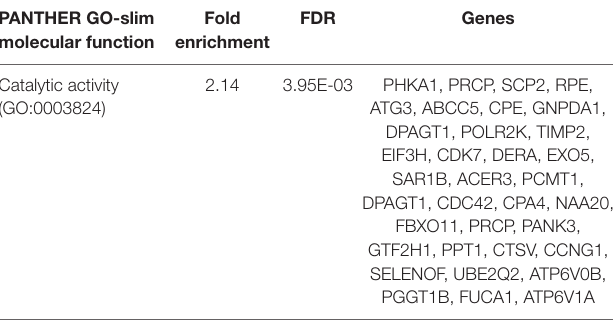
TABLE 9 | Enrichment of genes overexpressed in ICM under “SC” versus “SF + PGE2” IVP conditions. PANTHER GO-slim Fold FDR molecular function enrichment